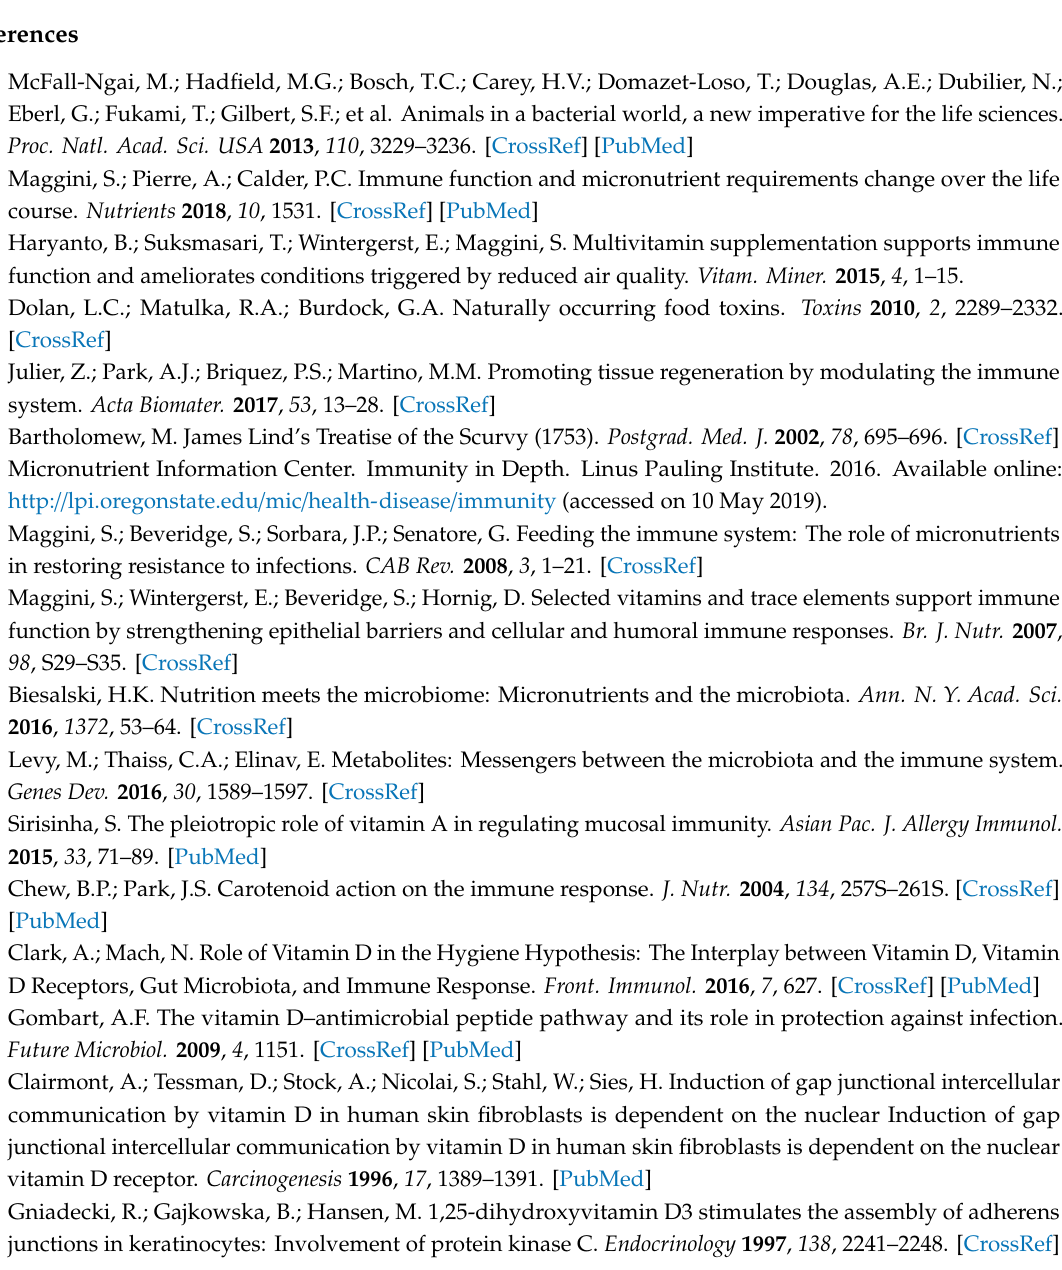
Table S1: Influence of micronutrients on the prevention and / or treatment of infections in adults and children: results from systematic reviews and